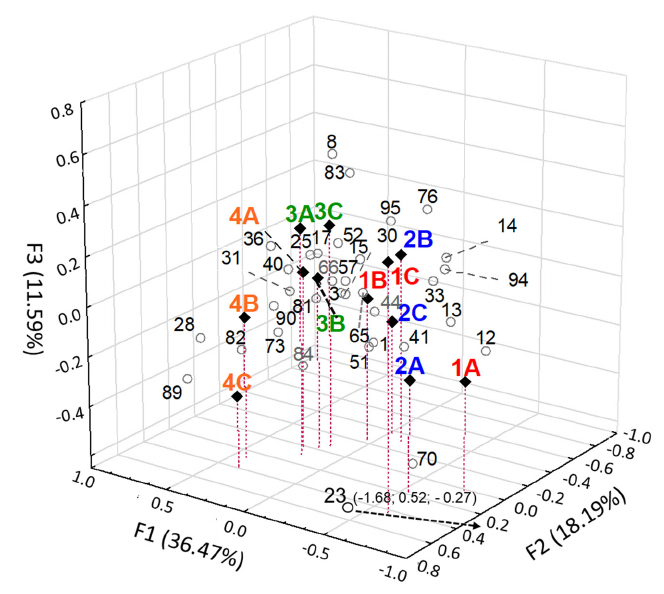
Figure A2. 3-D plot (dimensions 1, 2, and 3) of a correspondence analysis (CA) between the 12 samples and the 34 discriminant OAs defined by their NIF values. OAs (light circles) are plotted according to their NIF in samples (plain diamonds), respectively. The CA plot is zoomed in for clarity, and the coordinates of the extra variable (23) indicated in brackets with its direction. The OA numbers are those found in Table 1. The sample names are colored for illustrative purpose, with pole 1 samples appearing in red, pole 2 samples in blue, pole 3 samples in green, and pole 4 ones in orange. CA independence test: Khi² = 5444 (critical value 408, α = 0.05), degrees of freedom = 363, p < 0.0001.